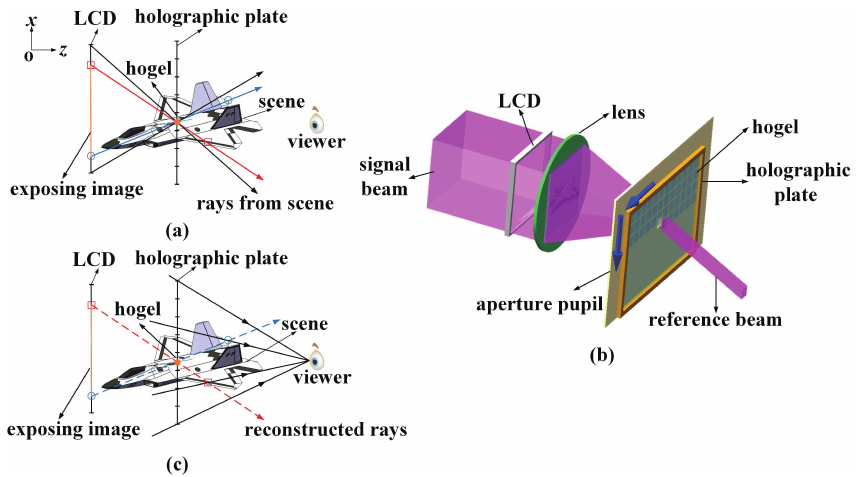
Figure 3. Principle of the single-step Lippmann method. ( a ) Calculation of an exposing image. ( b ) Optical setup of the method. ( c ) Reconstruction geometry for the holographic stereogram. (Reprinted with permission from ref [29], [OSA]).